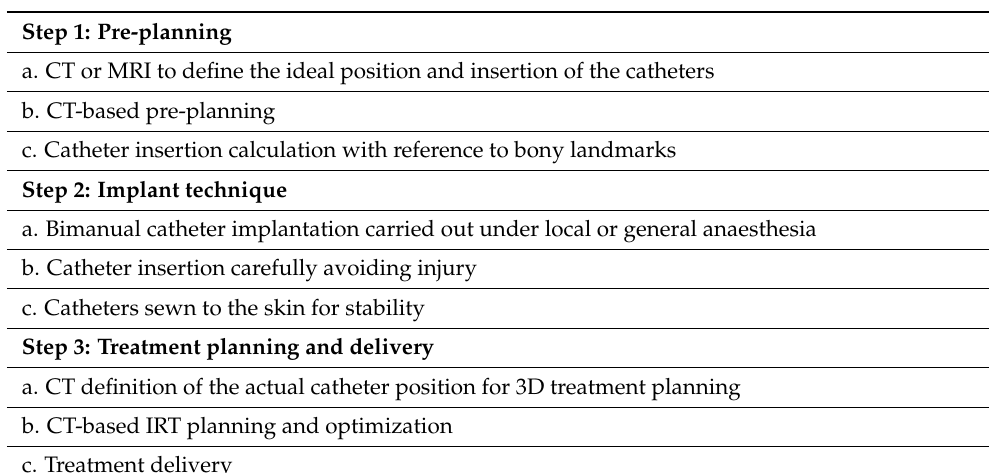
Table 2. Procedure